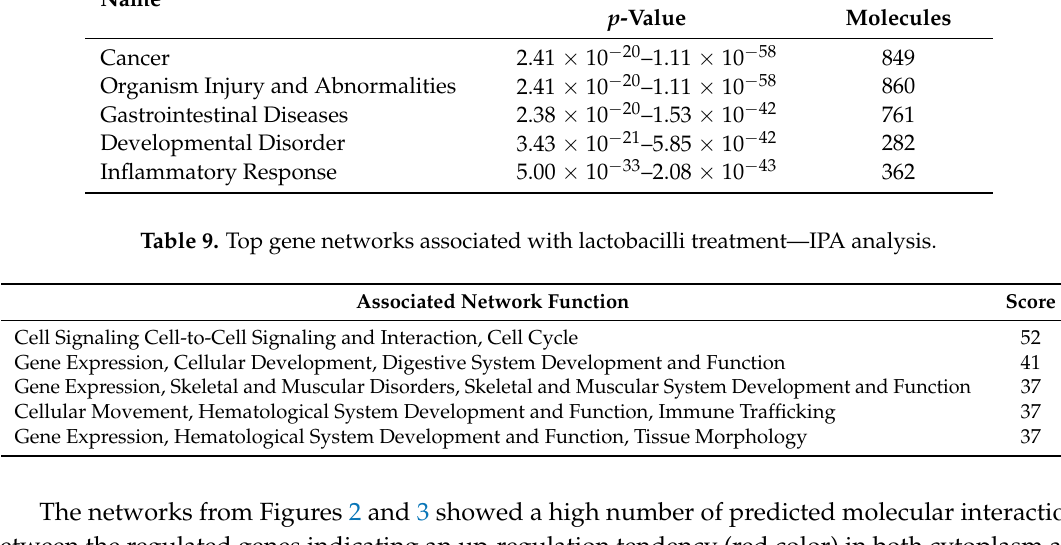
Table 8. Top gene Diseases and Bio Function associated with lactobacilli treatment—IPA analysis.